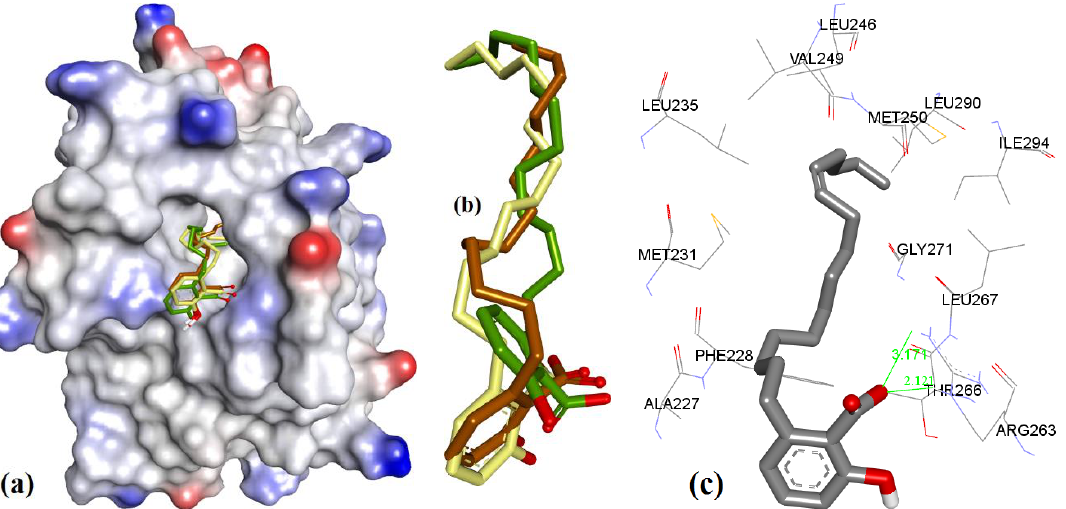
Figure 12. ( a ) The ionized solvent-exposed surface mapping of hMcl-1 along with the docked poses of 3g from MOE (in brown), AutoDock (in green), and VlifeDock (in yellow) show their fitting to the cavity. ( b ) Similar-pose ensemble clustering of all three poses was attained from the three different docking methods. ( c ) Binding mode of 3g .